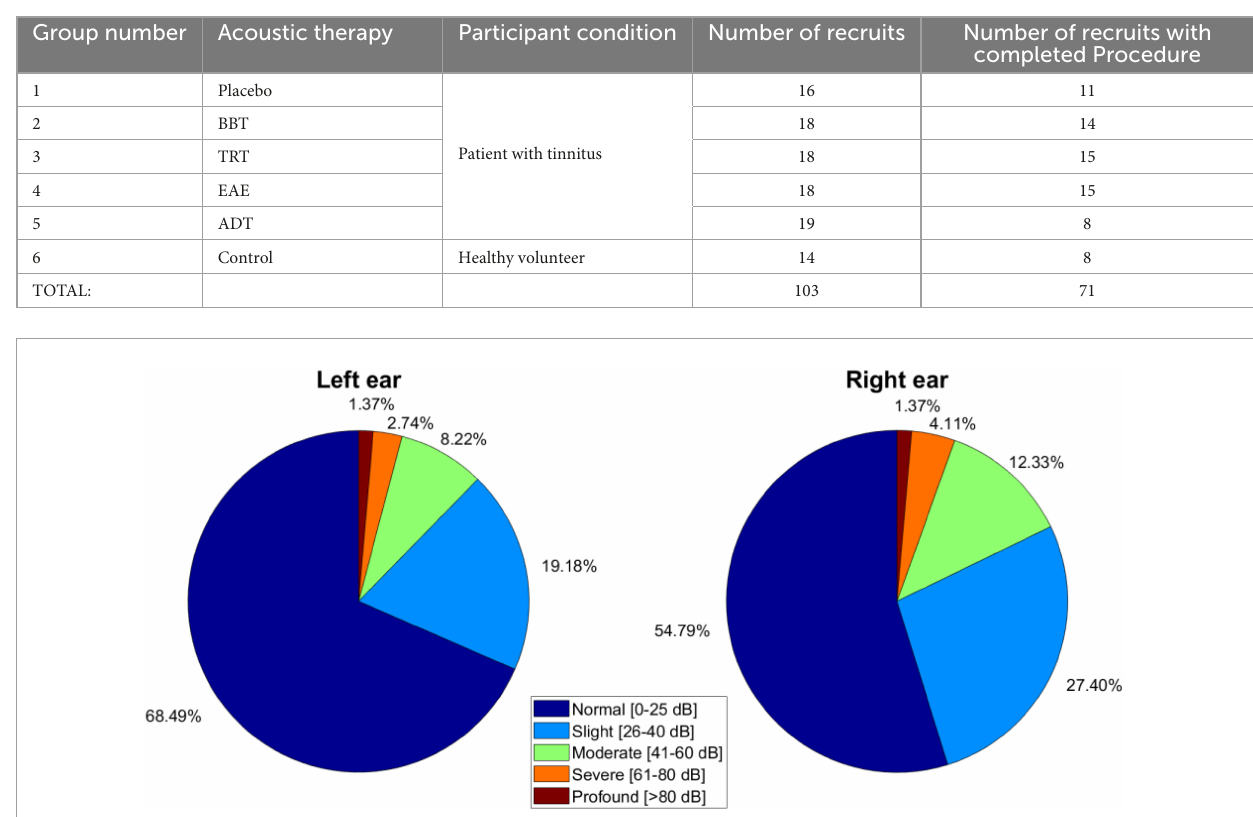
TABLE 2 In total, 103 of participants accepted to participate in the study, and 71 of them completed the experimental procedure.